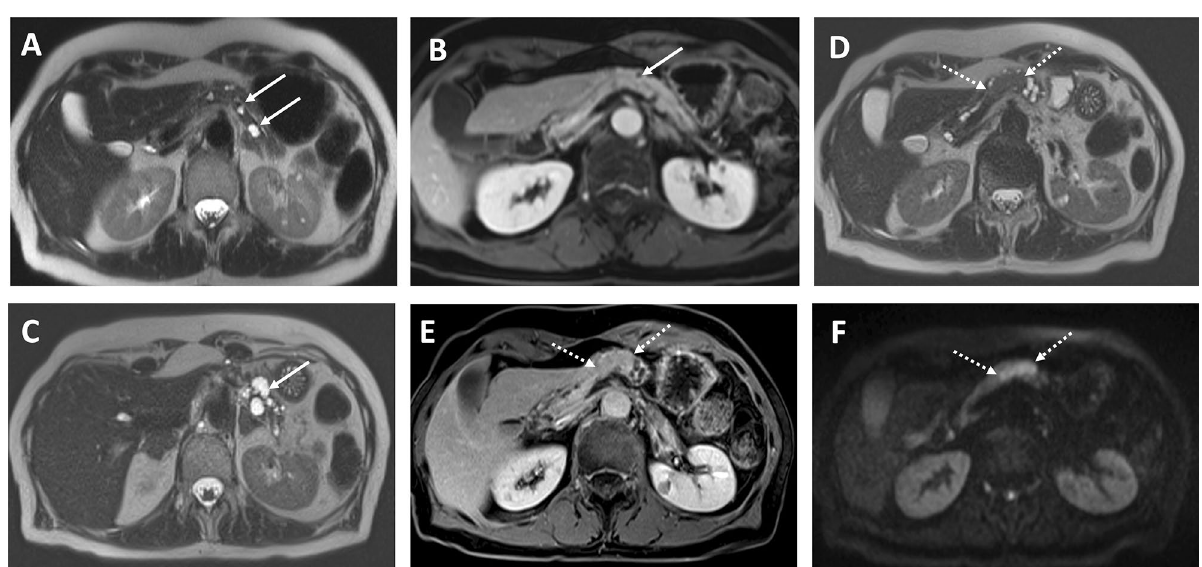
Figure 5. Cystic pancreatic lesions with development of solid ITPN in the pancreatic body. ( A,B ) Initial MRI study with cystic pancreatic lesions. ( A ) Axial T2 weighted image shows small cystic lesions (arrows) in the pancreatic tail without dilatation of the main pancreatic duct, suggesting small branch duct IPMNs. ( B ) Axial T1 weighted image after contrast medium administration in the portal venous phase. Tiny cystic lesion without contrast enhancement (arrow). No evidence of the tumor in the pancreatic body. ( C–F ) Follow-up of the same patient in 7 years. ( C ) Axial T2 weighted image, known cystic lesions in the pancreatic tail significantly increased in size (arrow). ( D ) Axial T1 weighted image after contrast medium administration in the portal venous phase. New lesion in the pancreatic body showing solid pattern of contrast enhancement being almost isointense to pancreatic parenchyma. ( E ) Axial T2 weighted image, elongated solid lesion within the pancreatic body (dotted arrows), which was histologically confirmed as ITPN after resection. ( F ) DWI with b-value 800 s/ mm 2 with restricted diffusion within the